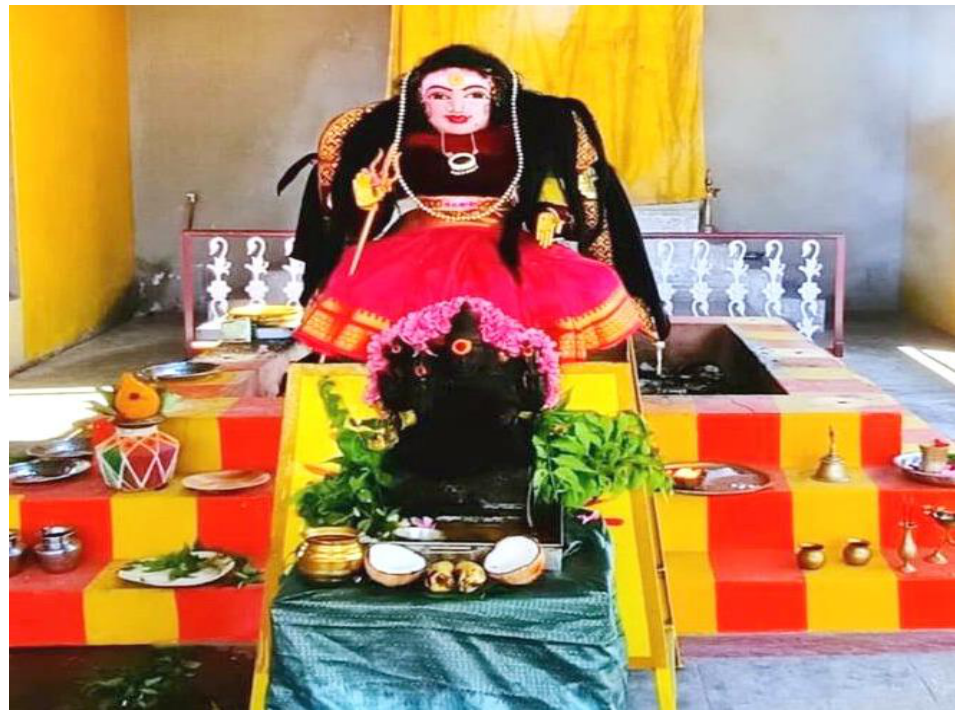
Figure 4. Corona M¯at¯a shrine with Mun.d. am¯al¯a and tri´s¯ul, Coimbatore, Tamil Nadu. Used with the Figure 4. Corona Mātā shrine with Mu ṇḍ amālā and triśūl, Coimbatore, Tamil Nadu. Used with th e photographer’s photographer’s permission.